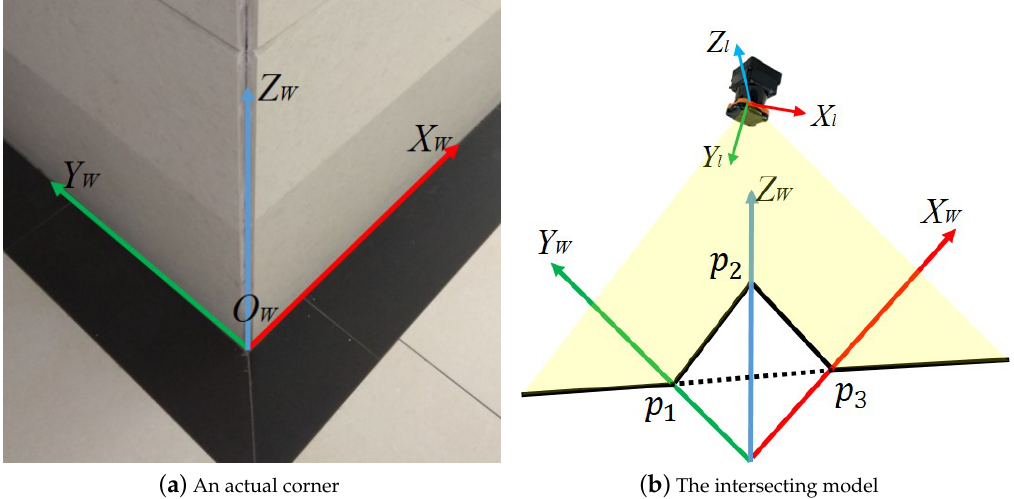
Figure 2. Trihedron model: ( a ) an actual corner and ( b ) the intersecting model of the LRF scanning plane with the